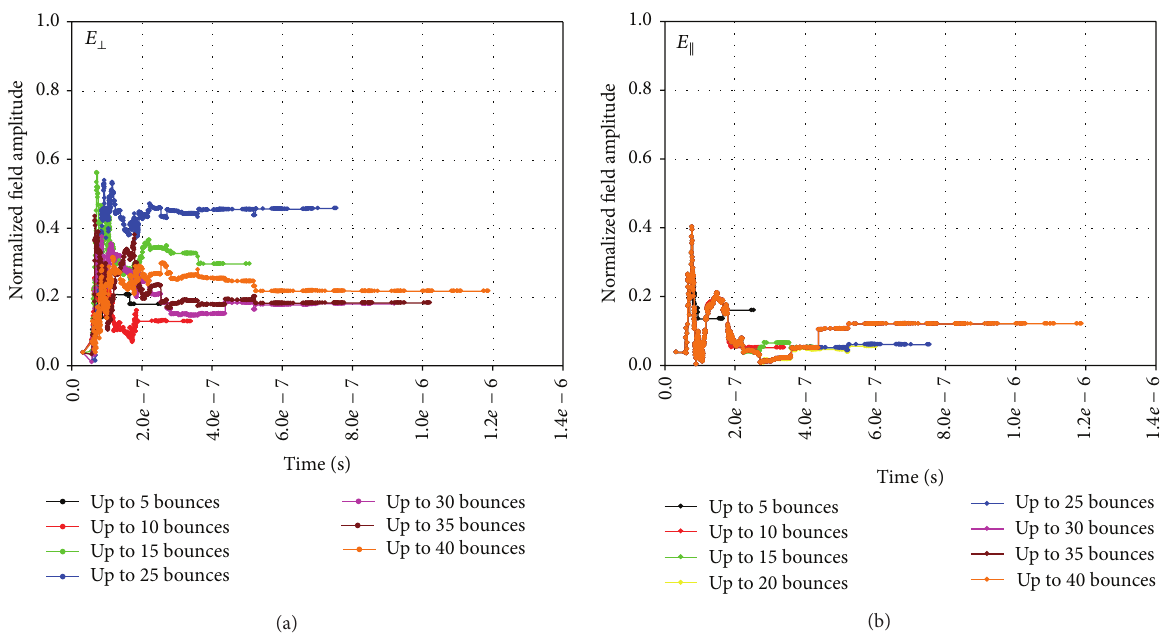
Figure 7: (a) RF field build-up inside a metallic space vehicle. Frequency = 8 GHz; 𝜎 = 1.8 × 10 5 S/m, polarization: perpendicular . Since the walls are metallic, convergence has not been achieved. (b) RF field build-up inside a metallic space vehicle. Frequency = 8 GHz; 𝜎 = 1.8 × 10 5 S/m, polarization: parallel. Since the walls are metallic, convergence has not been